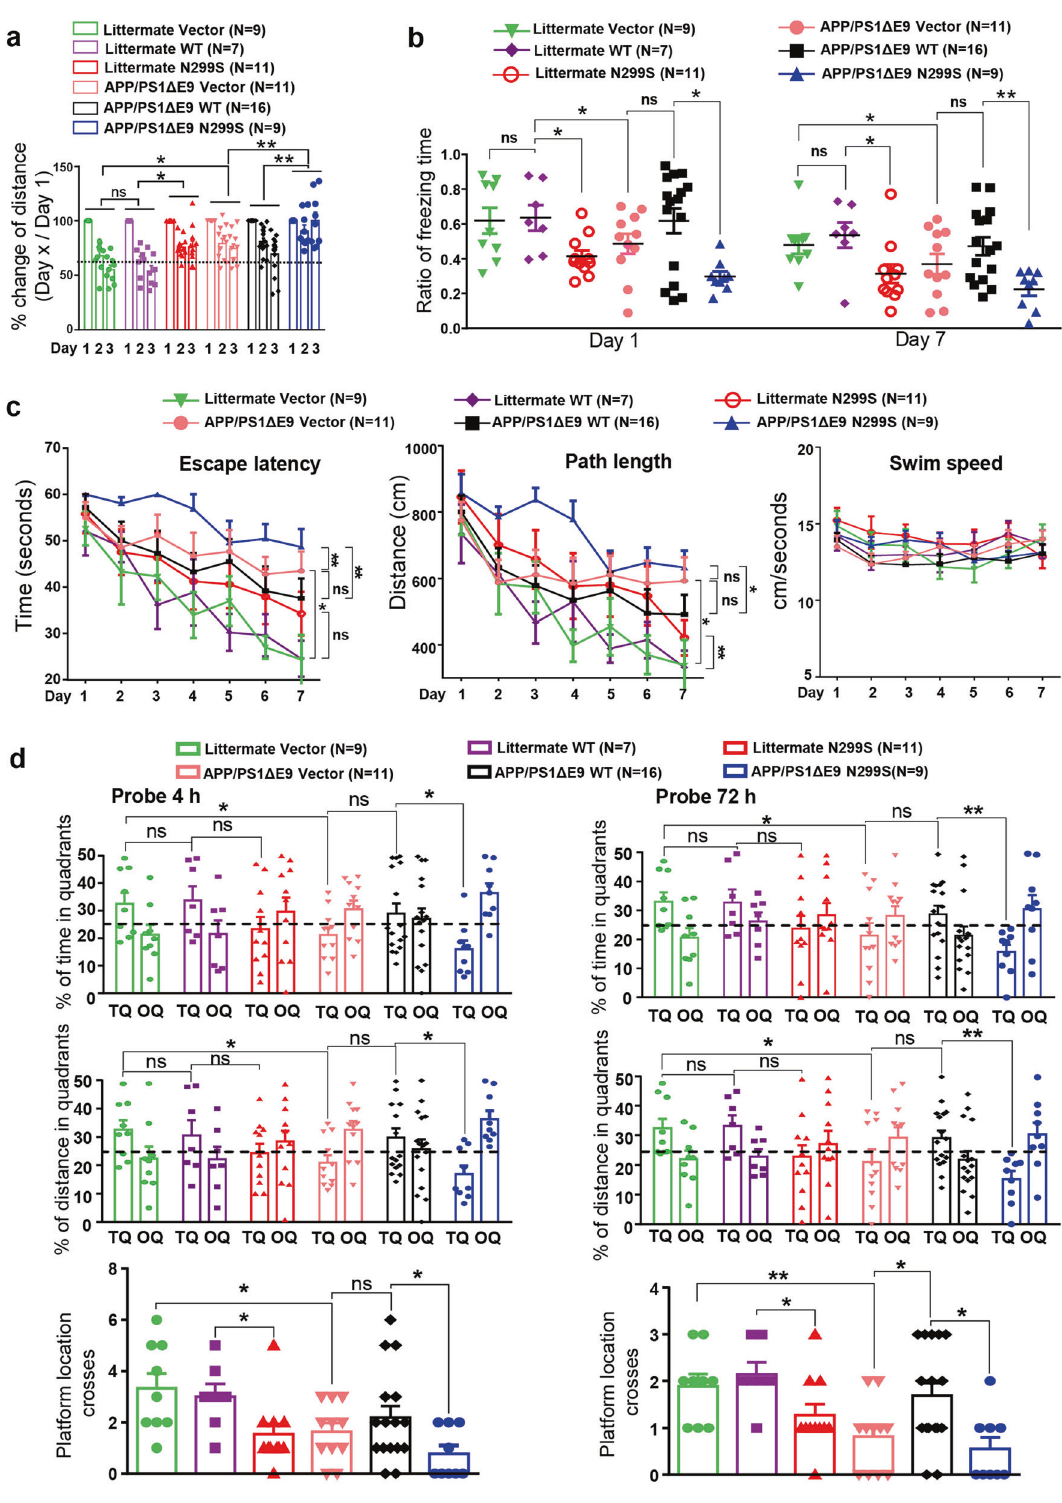
to the AAV-Vector group in APP/PS1 Δ E9 mice in the 72-h probe trial, indicating potentially bene fi cial effect of delay in the development of AD in this murine model (Fig. 3d). Taken together, these behavioral tests suggested a detrimental effect of ACAA1 p. N299S during the memory consolidation phase.